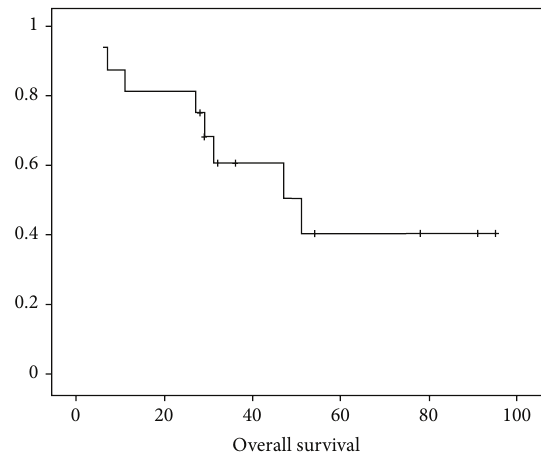
Figure 2: The Kaplan-Meier curve showing overall-survival